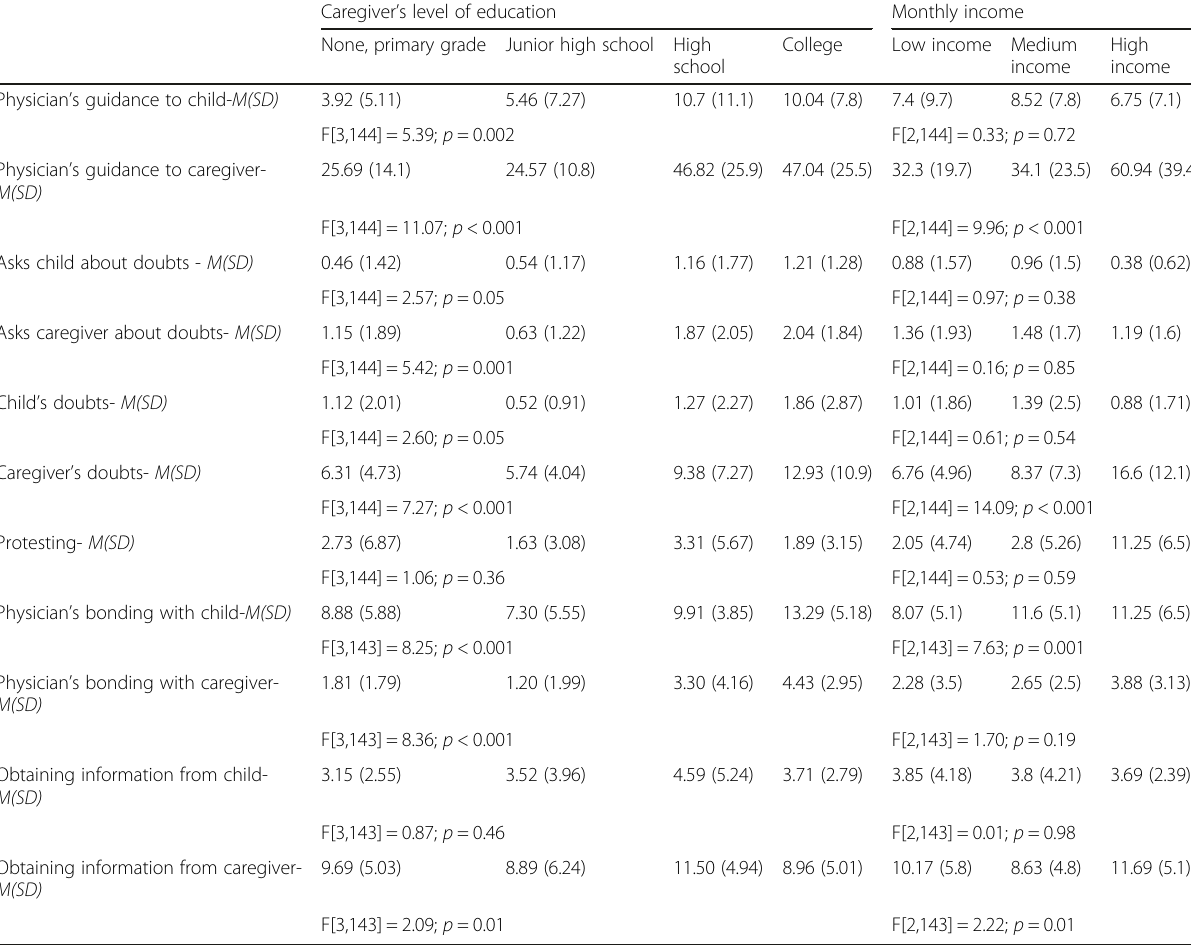
Table 5 Associations between Communicative Behaviors and the Caregiver ’ s level of education and Monthly Income Caregiver ’ s level of